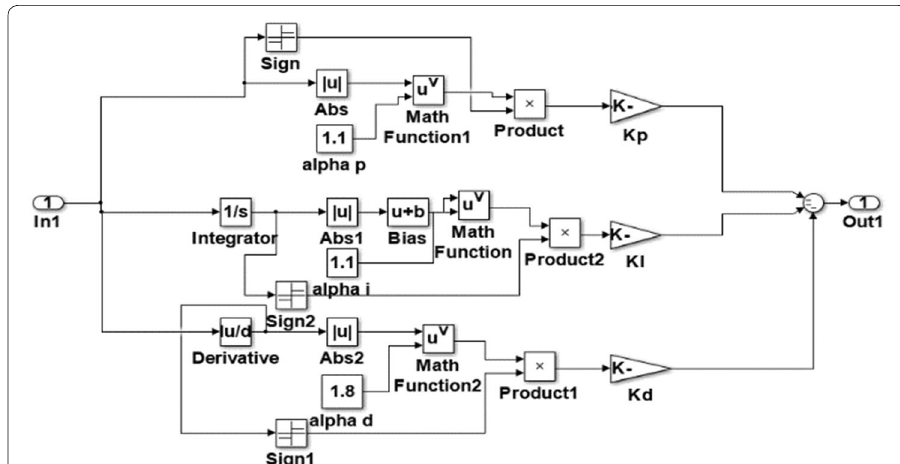
Fig. 8 Structure of nonlinear PID controller [12]